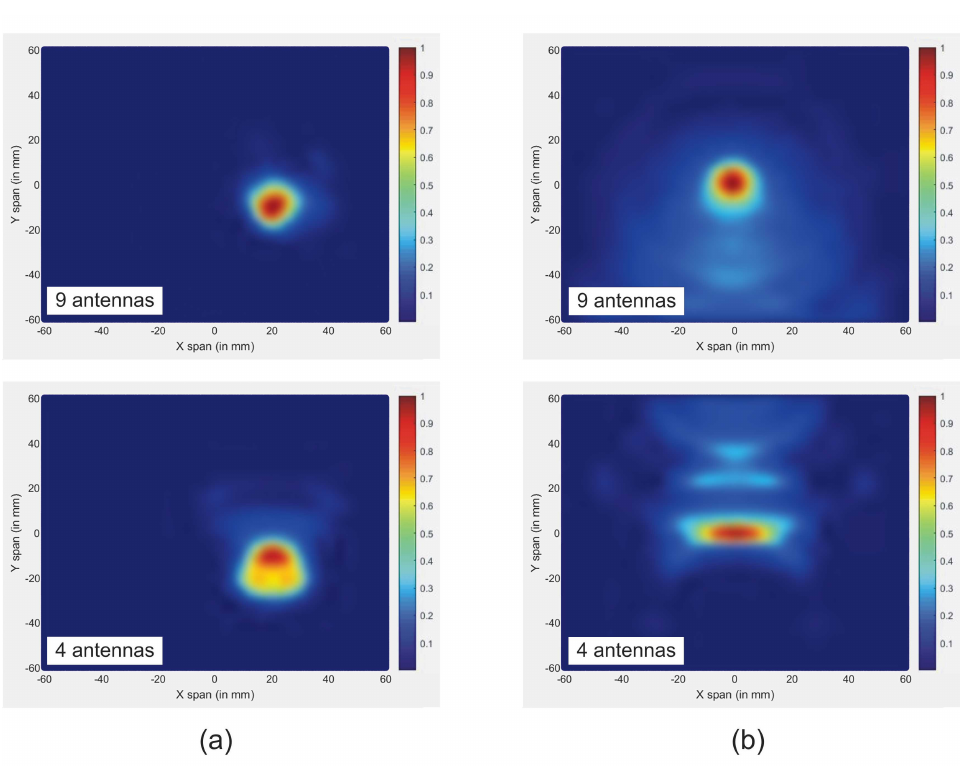
Figure 10. Reconstructed images of tumor for both methods using different number of antennas: ( a ) new approach; ( b ) traditional approach.